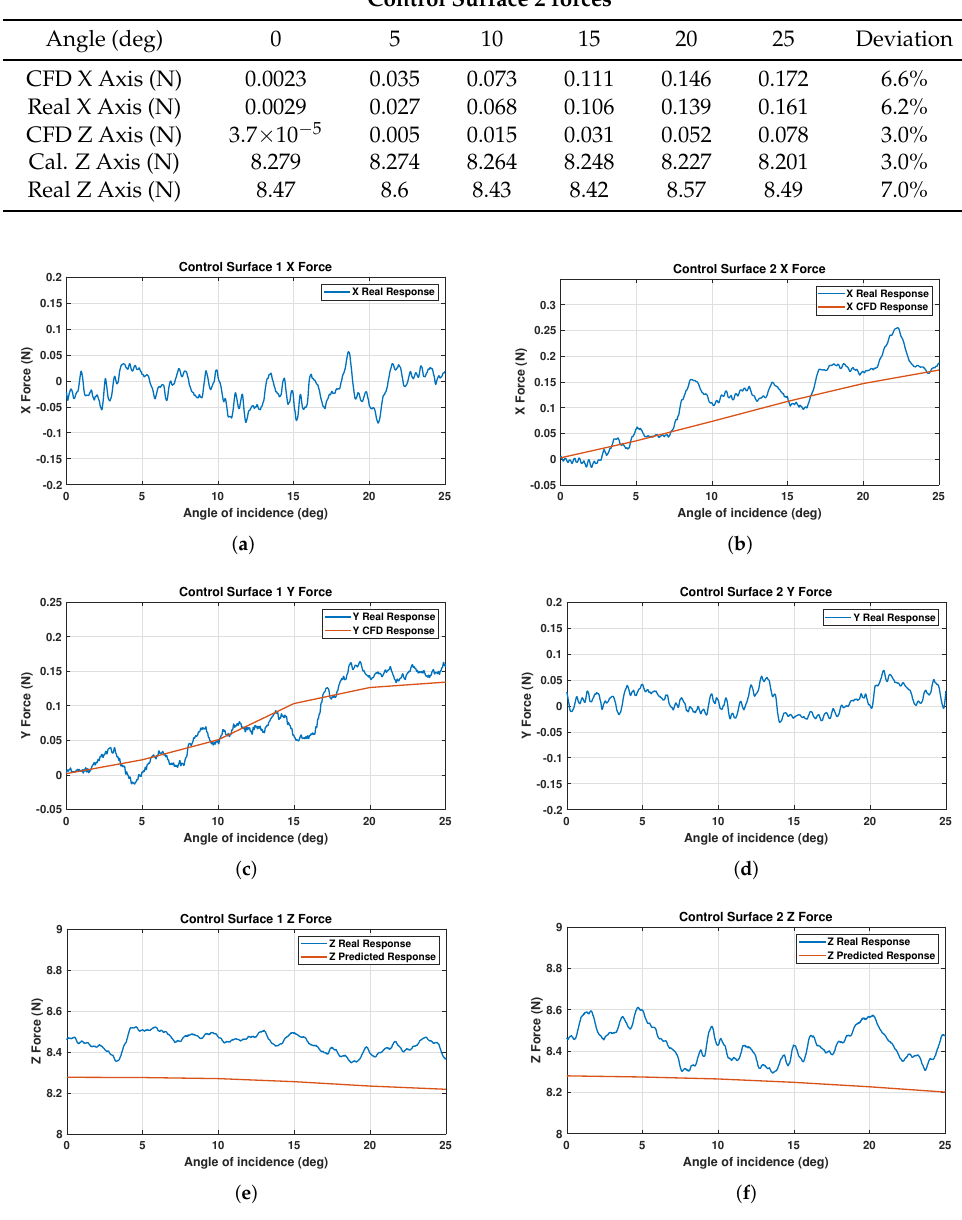
Figure 24. Experimental data vs. CFD for both control surfaces. ( a ) Control Surface 1, real X force vs. CFD. ( b ) Control Surface 2, real X force vs. CFD. ( c ) Control Surface 1, real Y force vs. CFD. ( d ) Control Surface 2, real Y force vs. CFD. ( e ) Control Surface 1, real Z force vs. CFD. ( f ) Control Surface 2, real Z force vs.